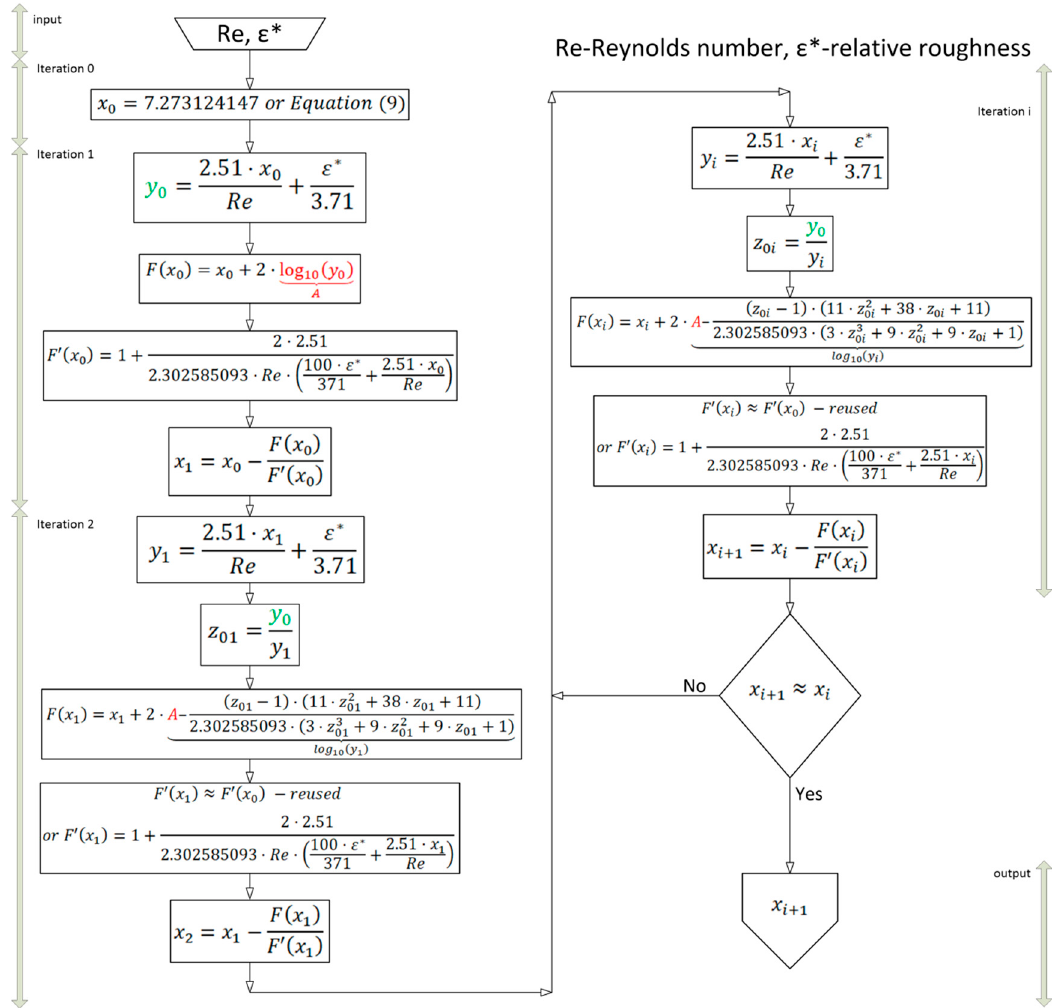
Figure 2. Algorithm for the proposed one (cid:1864)(cid:1867)(cid:1859) -call improved procedure.